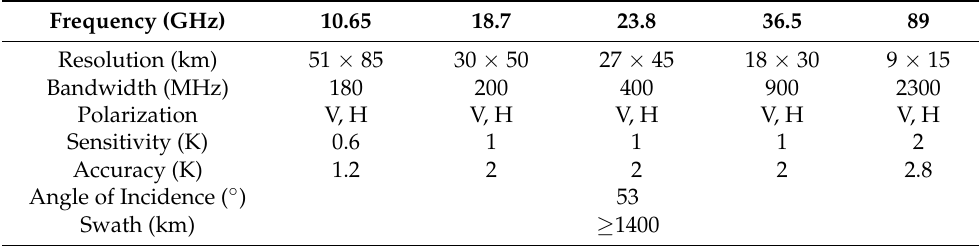
Table 1. Parameters of FY-3B MWRI (Microwave Radiation Imager)